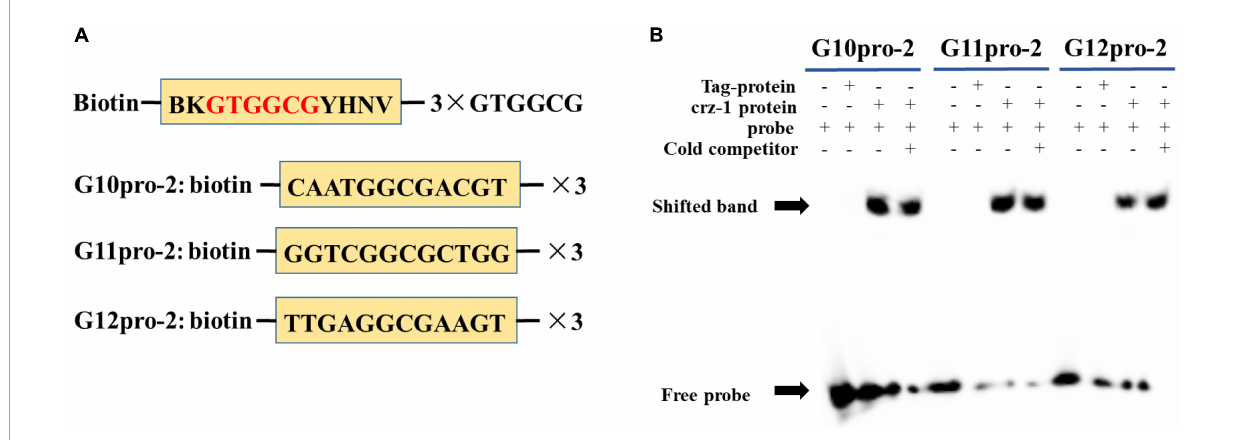
FIGURE5 PuCRZ1 binds to the site in the PuG10 , PuG11 , and PuG12 promoter in vitro . (A) Schematics of cis- elements in EMSA probes. (B) Electrophoretic mobility shift assays (EMSA) showing that PuCRZ1 specifically binds to the GTGGCG-motif. In (B) an excess of the cold, unlabeled probe was used as a competitor (lane 4/8/12).